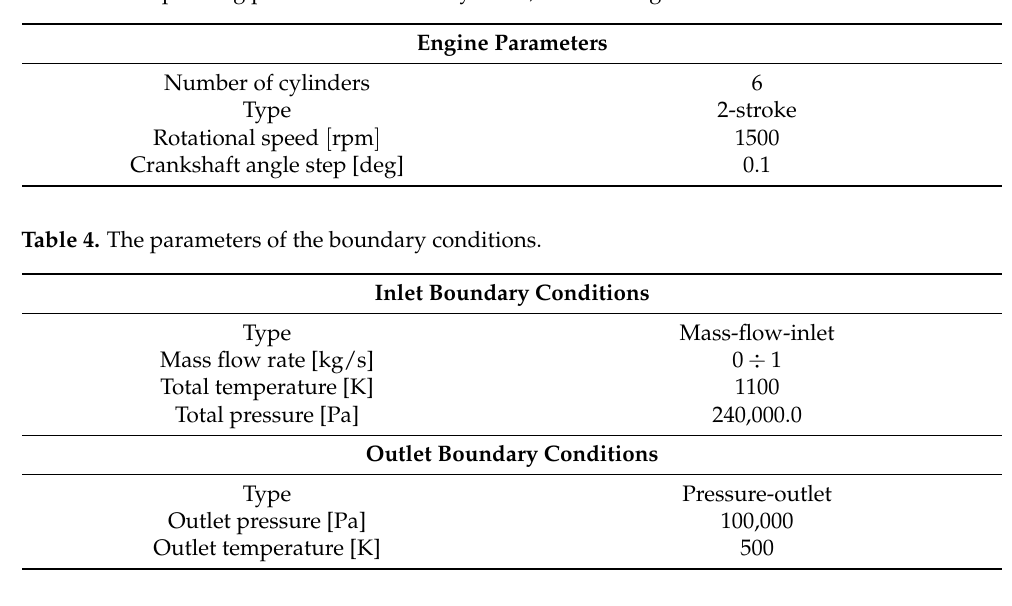
Table 3. The operating parameters of the 6-cylinder, 2-stroke engine.